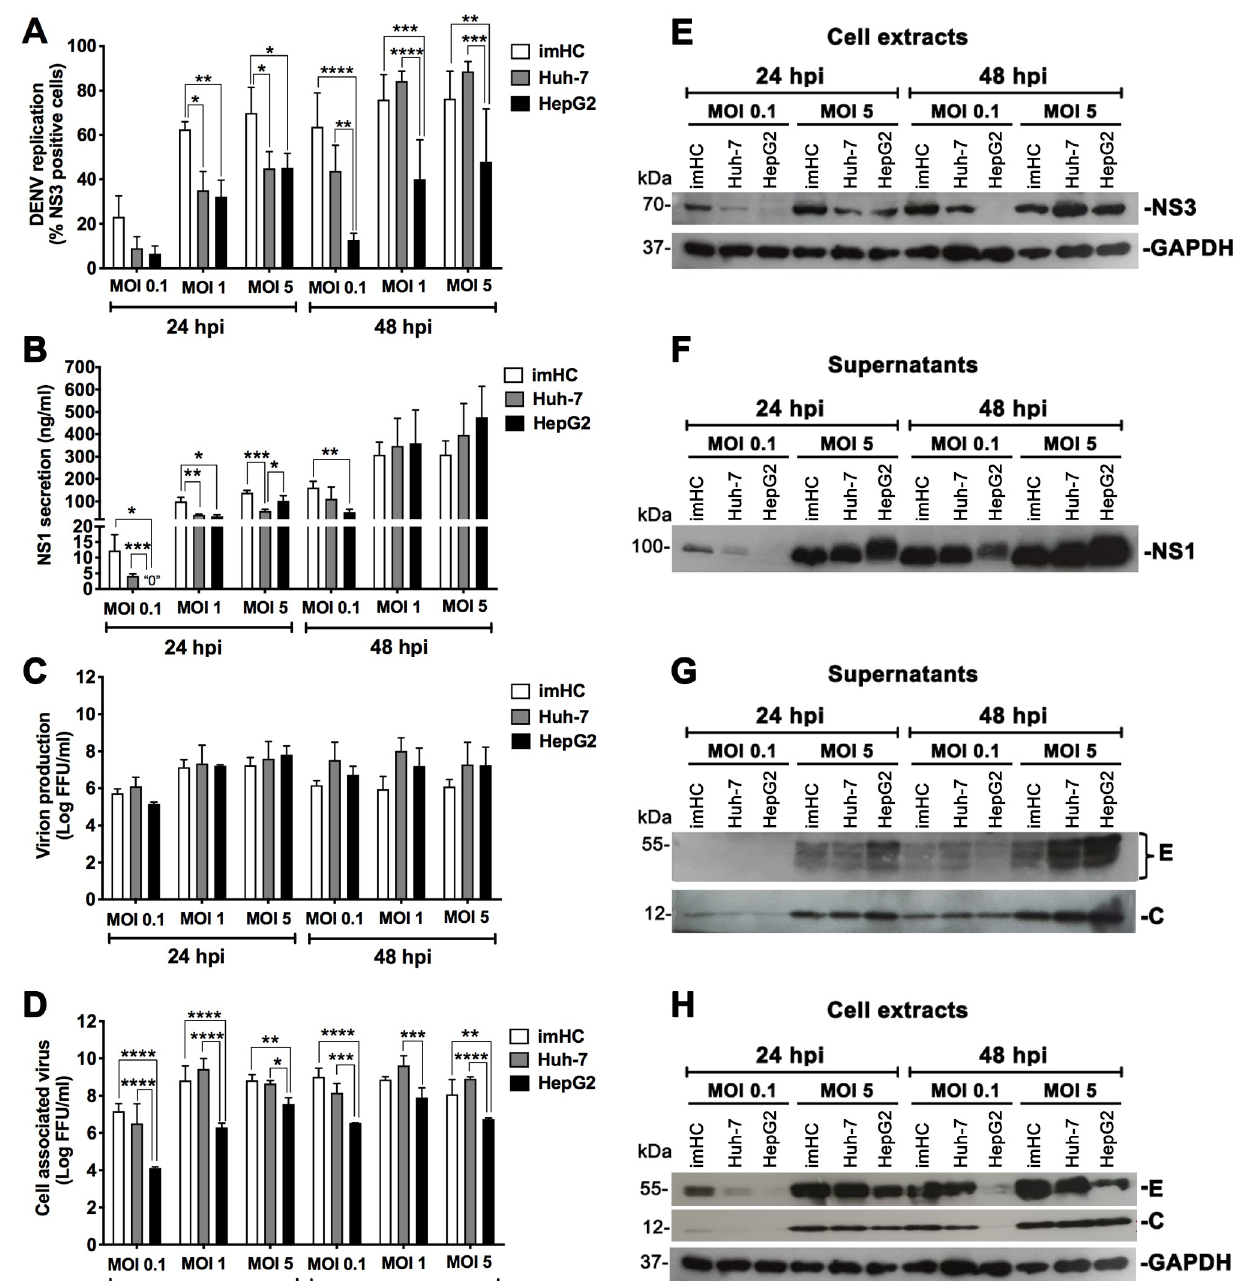
Fig 2. Efficiency of imHC in DENV replication and production in comparison with hepatoma cell lines. The three hepatic cell lines were cultured in 24-well plates and infected with different MOIs of DENV-2 (0.1, 1 and 5). The cells and the culture supernatants were collected at 24 and 48 hpi. Intracellular expression levels of NS3, a DENV antigen representing DENV replication, were determined by immunofluorescence and flow cytometry ( A ). NS1 secretion levels were determined by ELISA ( B ). The infectious virion production levels in supernatants ( C ) and cell-associated viruses in cell extracts ( D ) were assessed by FFU assay. The data are presented as mean ± S.D. of values from three independent experiments. Asterisks indicate significant differences among cell types at the specified time point ( � P < 0.05; �� P < 0.01; ��� P < 0.001; ���� P < 0.0001). Levels of intracellular NS3 ( E ), secreted NS1 ( F ), extracellular virion E and C proteins ( G ) and cell-associated DENV E/C antigens ( H ) were evaluated by Western blotting analysis. Cell lysates containing equal amounts of proteins (15 μ g/sample) or equal volumes of supernatants (10 μ l/sample) were used for Western blotting. GAPDH was used as endogenous protein control for cell